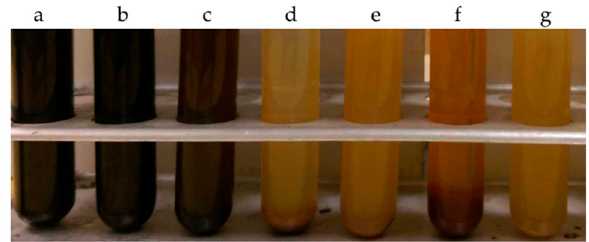
Figure 3. The visual effect of the raw liquid fraction of digestate treatment ( a —raw liquid fraction of digestate; b —after 10 g/dm 3 of PIX 112; c —after 10 g/dm 3 of CaO; d —after 10 g/dm 3 of FeCl 3 ·6H 2 O; e —after 20 g/dm 3 of PIX 112; f —after 20 g/dm 3 of CaO; g —after 20 g/dm 3 of FeCl 3 ·6H 2 O).